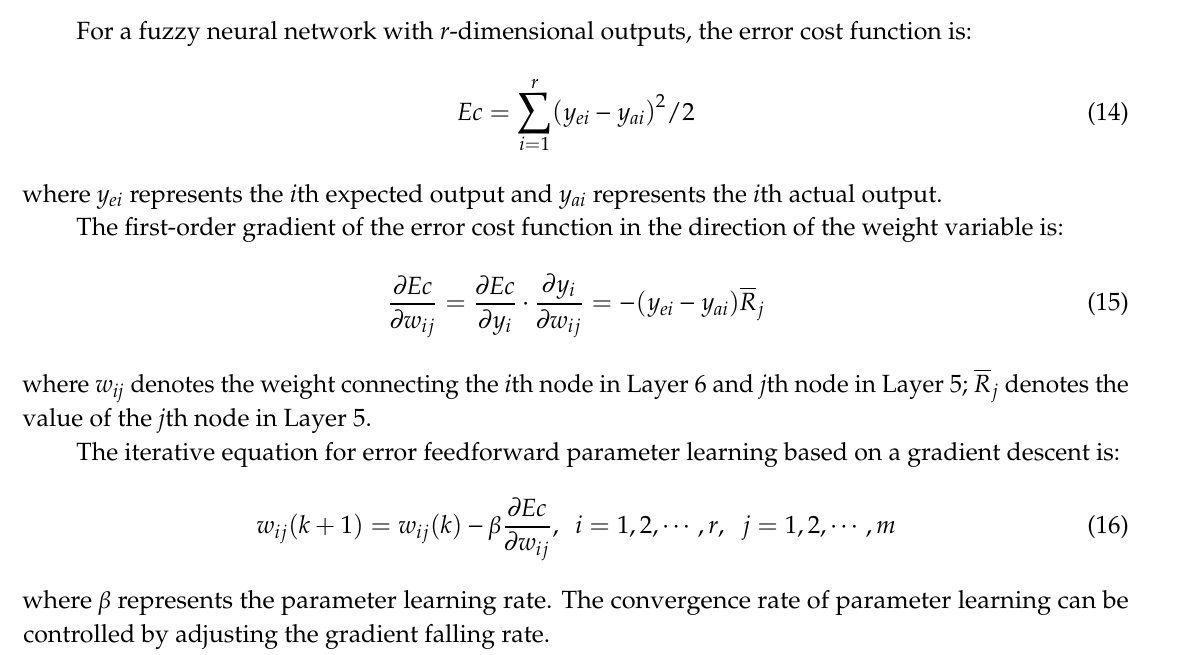
Figure 3. Flow chart of error feedforward algorithm based on gradient